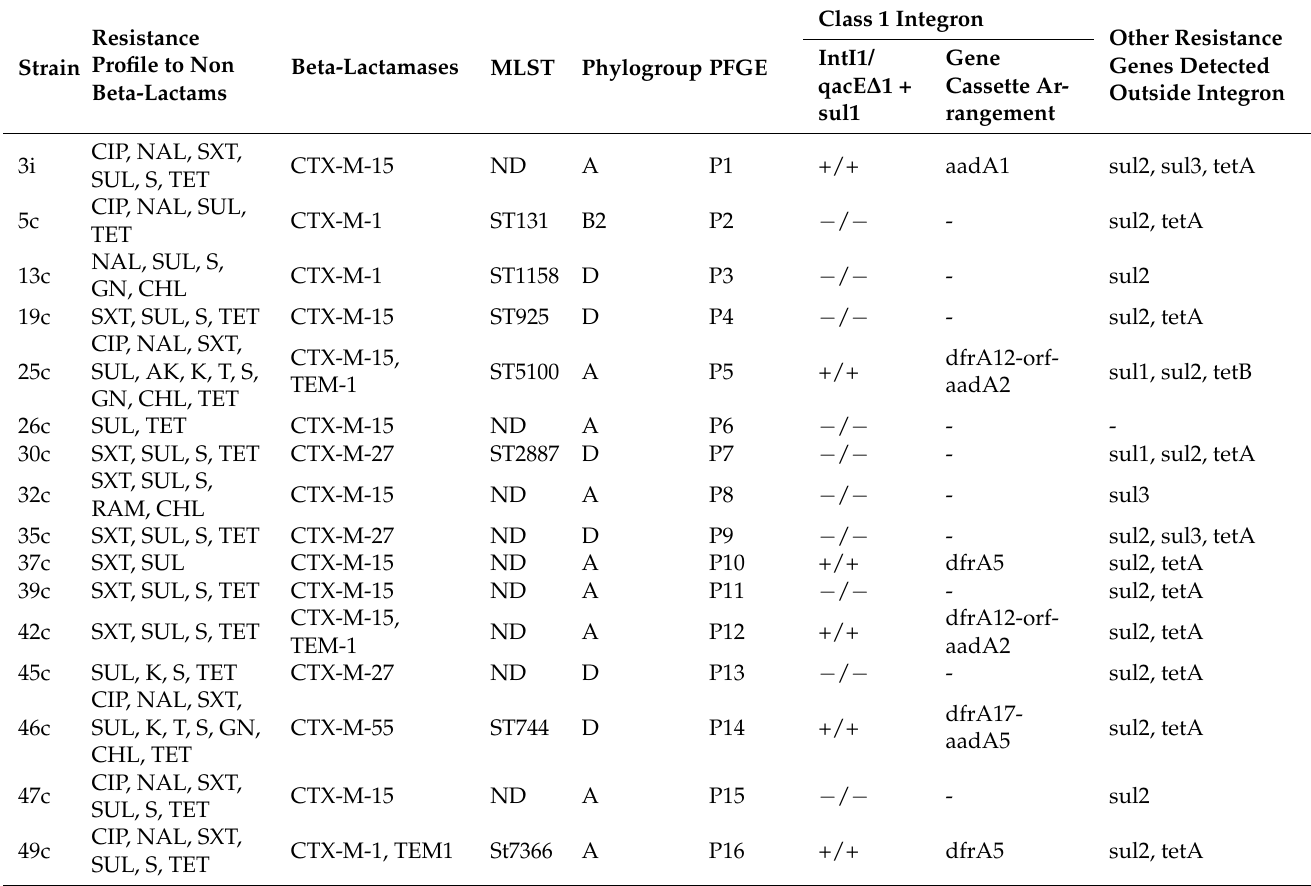
Table 2. Characteristics of the 16 ESBL-producing E. coli isolates recovered from the fecal samples of healthy